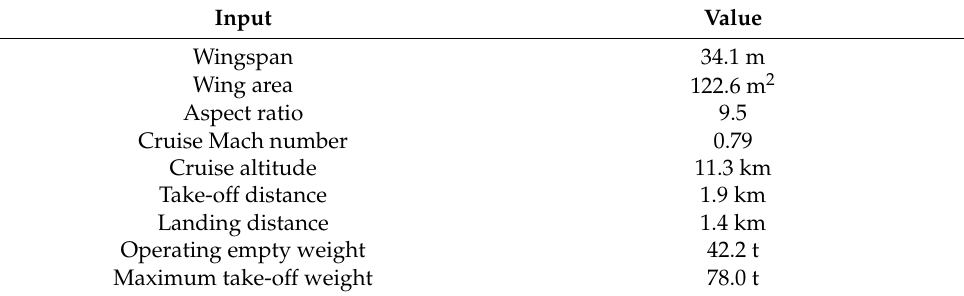
Figure 6. ( a ) Mission profile and ( b ) take-off path based on conventional aircraft specifications (adapted from [42]). Table 2. A320 specifications compiled using data from [43].